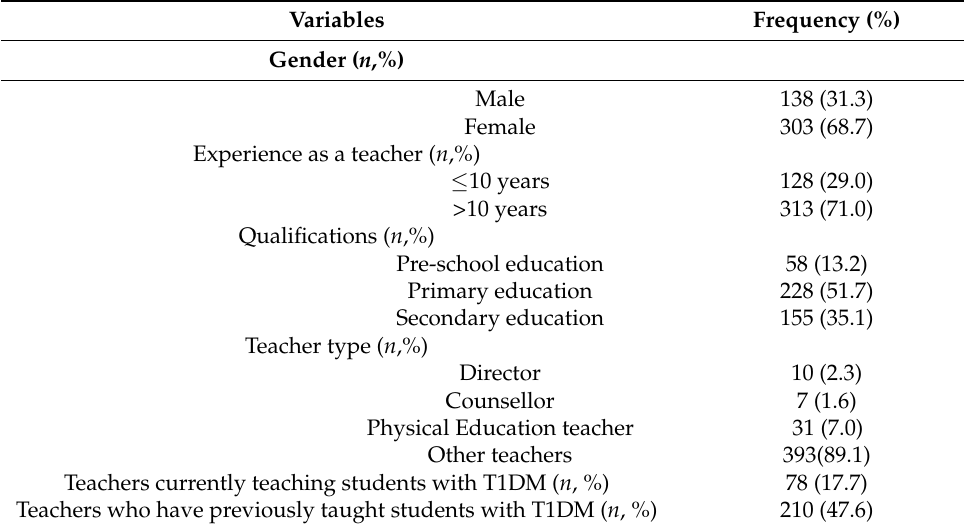
Table 1. Characteristics of teachers included in the study ( n = 441).